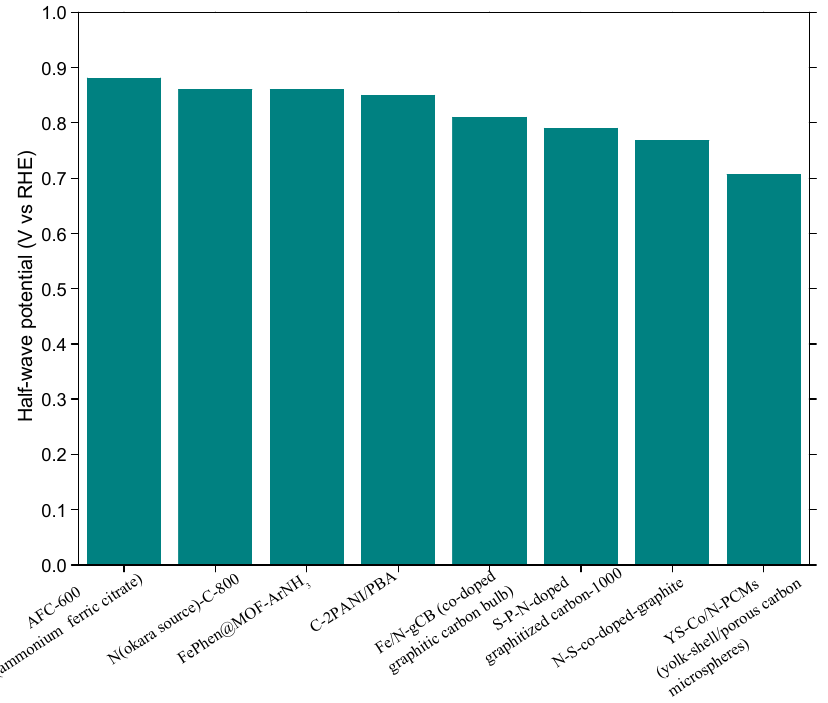
Figure 5. Comparison of half-wave potential of modified-alternative raw electrocatalytic materials. (Ref. from left to right bar: [74], [75], [77], [73], [76], [78], [80], [79]).